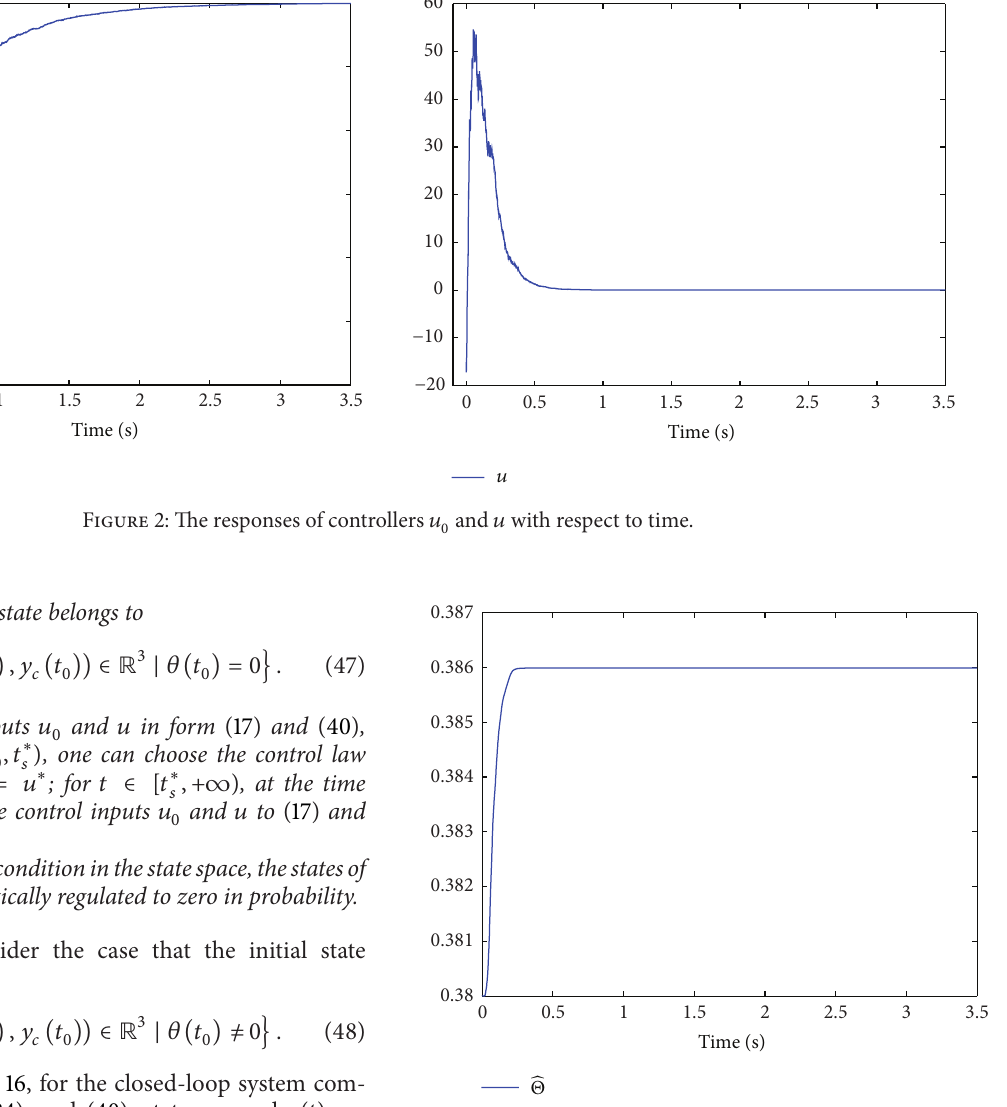
Figure3:Theresponseofestimateparameter